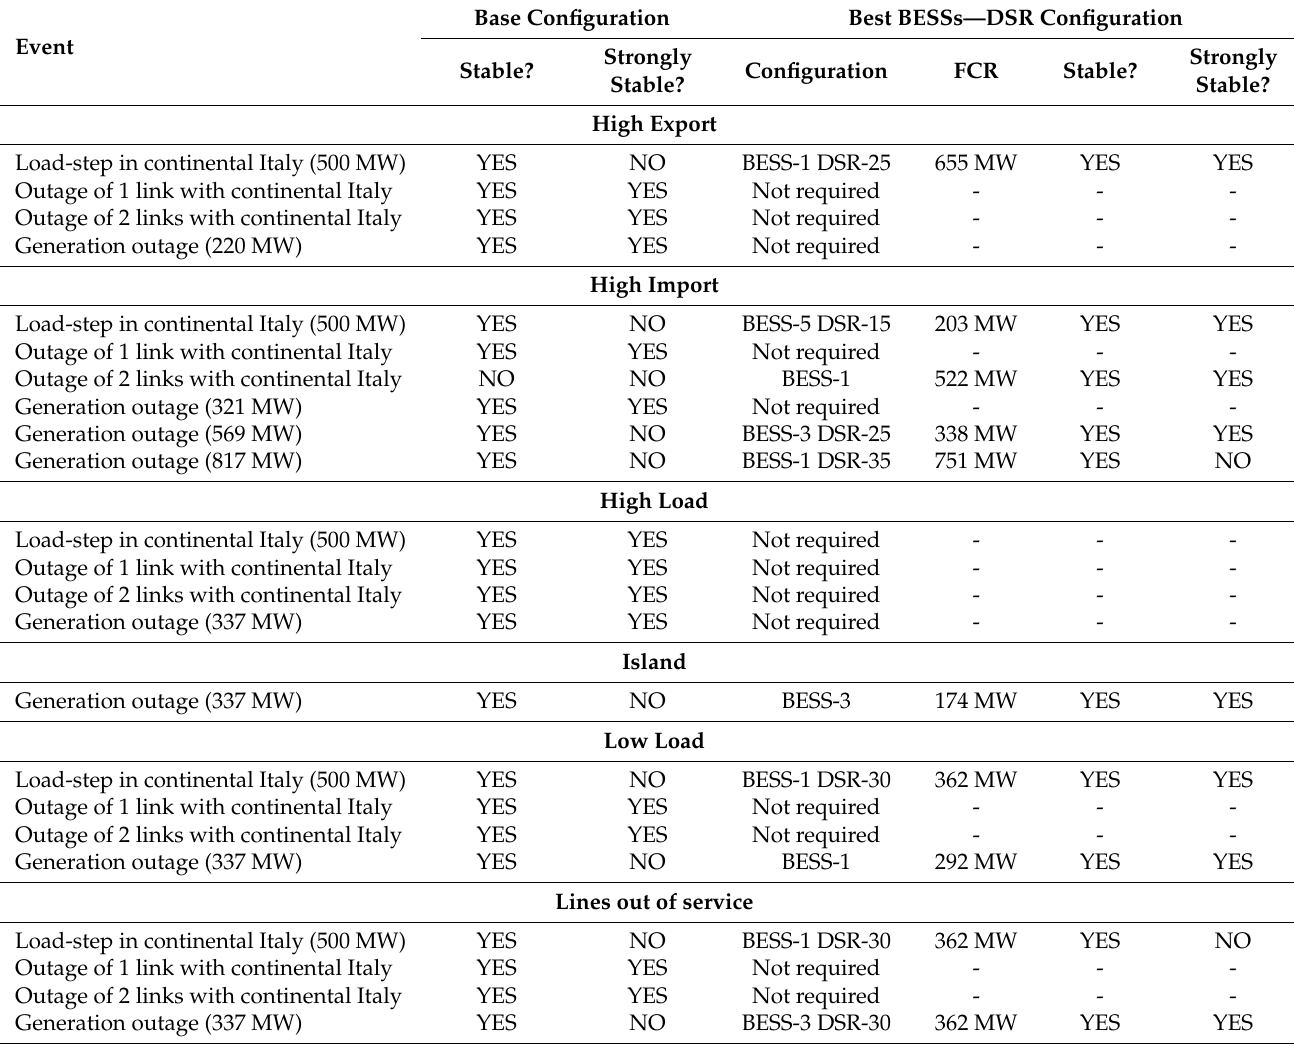
Table 9. Large perturbation stability analysis: simulation